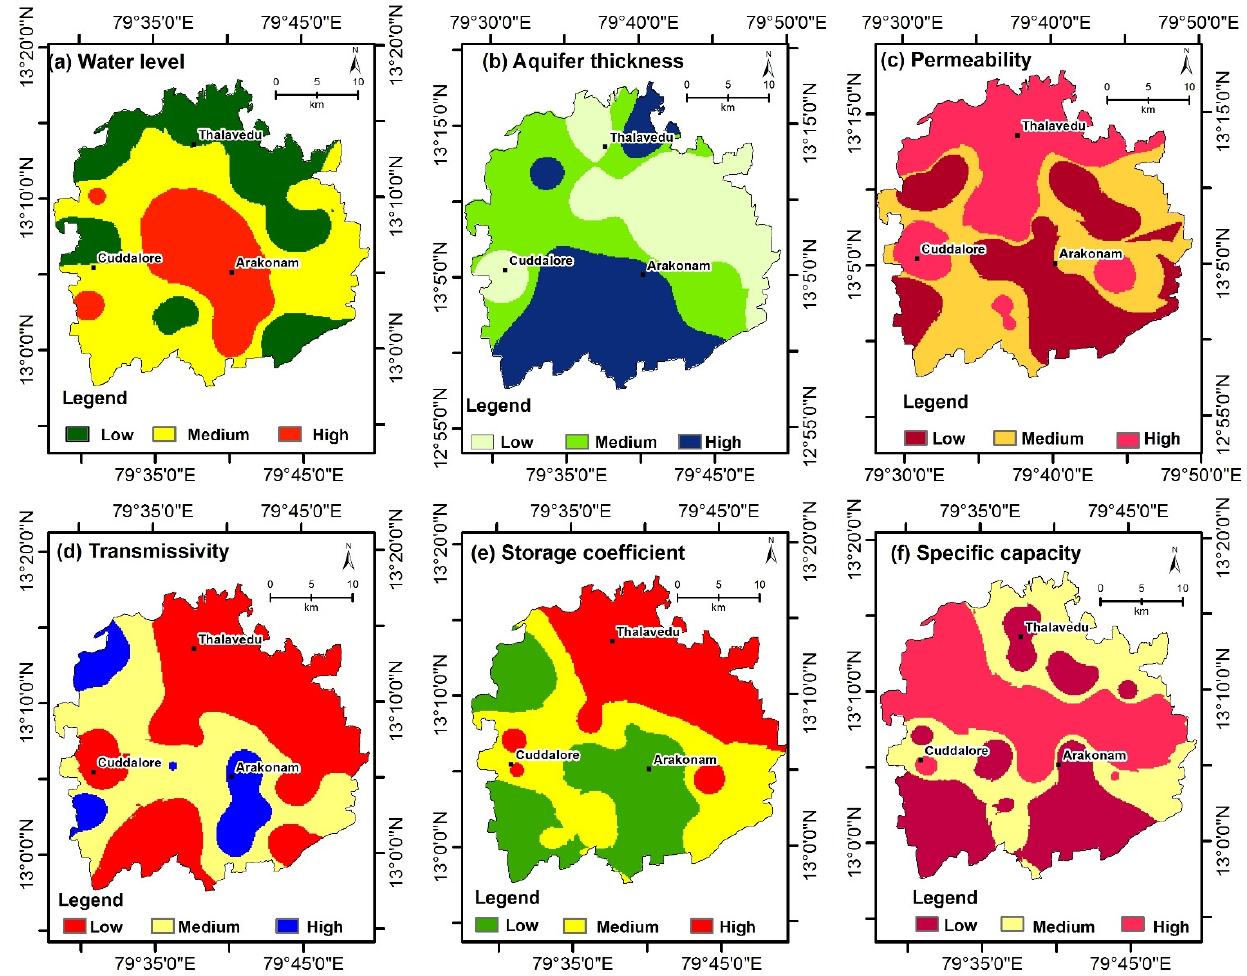
Figure 5. ( a – f ) Thematic layers on subsurface groundwater influencing parameters.